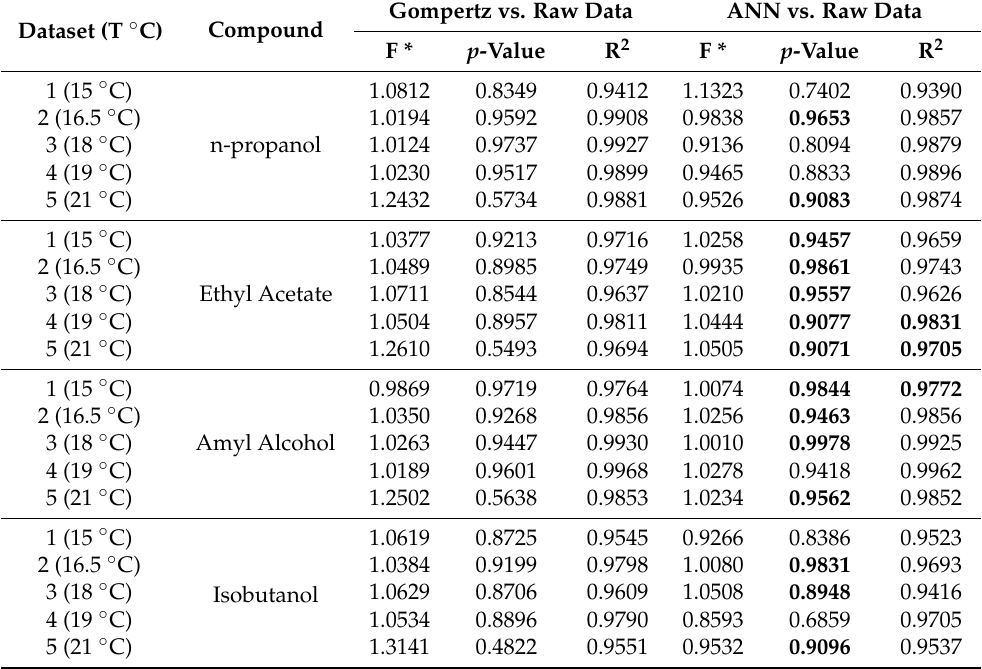
Table 3. Statistical comparison for Gompertz and ANNs functions vs RAW data. The F and p statistics are the result of the analysis of variance. Dataset (T ◦